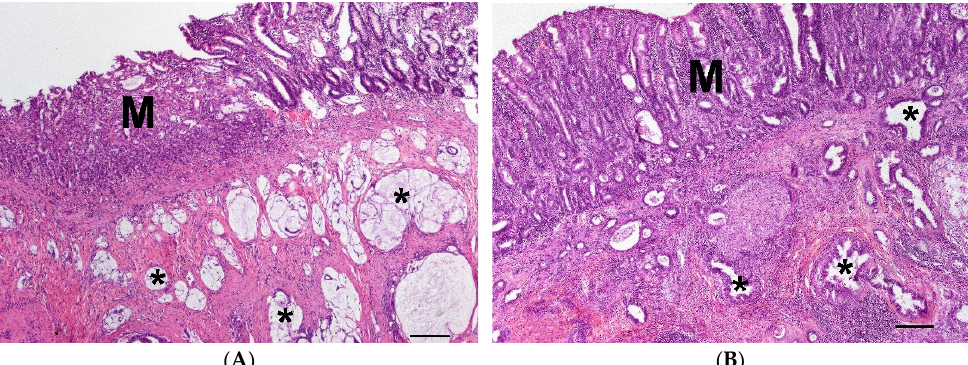
Figure 4. ( A ) Carcinoma in the jejunum with ulcerated mucosa (M) and mucinous neoplastic growth pattern (asterisk) in the muscularis of a 12-year-old male dog of unknown breed; (HE, bar = 200 µm). ( B ) Carcinoma in the large intestine with moderate inflammation of the mucosa (M) and tubular neoplastic growth pattern (asterisk) in the muscularis of a 10-year-old male mix; (HE, bar = 200 µm). The carcinomas of the large intestine (4L, n = 13) mainly had a tubular ( n = 7, Figure 4B), papillary ( n = 3), mucinous ( n = 2) or anaplastic ( n = 1) growth pattern and infiltrated